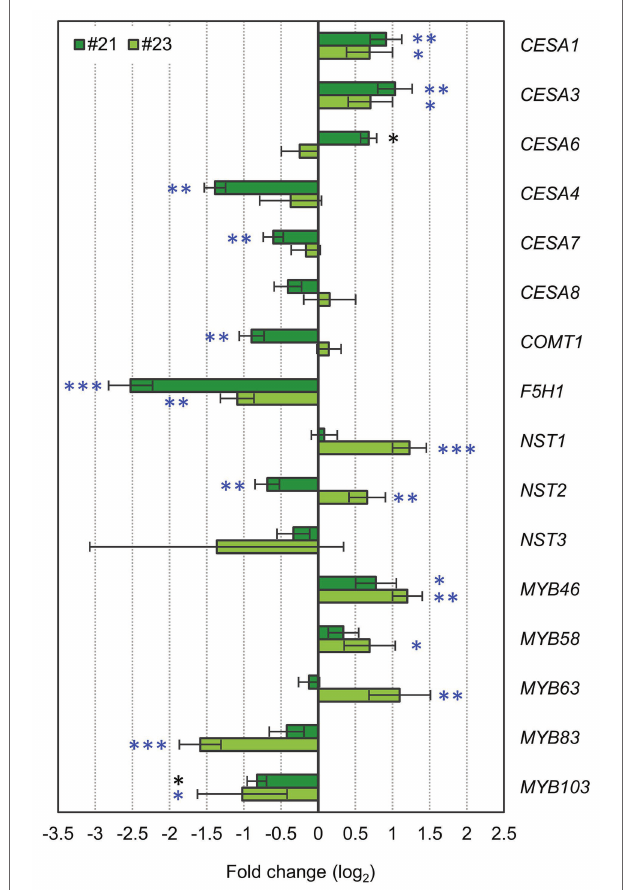
FIGURE 6 | ERF041-VP16 affects primary cell wall (PCW)- and secondary cell wall (SCW)-related genes. Fold changes of PCW- or SCW-related genes. Data represent mean ± SD performed by biological triplicates ( CESA6 , MYB83 , and MYB103 ) or quadruplicates (the other genes). * p < 0.05, ** p < 0.01, and *** p < 0.001 by Student’s t test. Blue asterisks show significant differences that are also detected using values of p adjusted by Benjamini-Hochberg method ( p < 0.05; Benjamini and Hochberg, 1995). Each expression level was normalized by the normalization factor, estimated from ACT2 , PP2AA3 , and UBQ1 data, and the mean of the